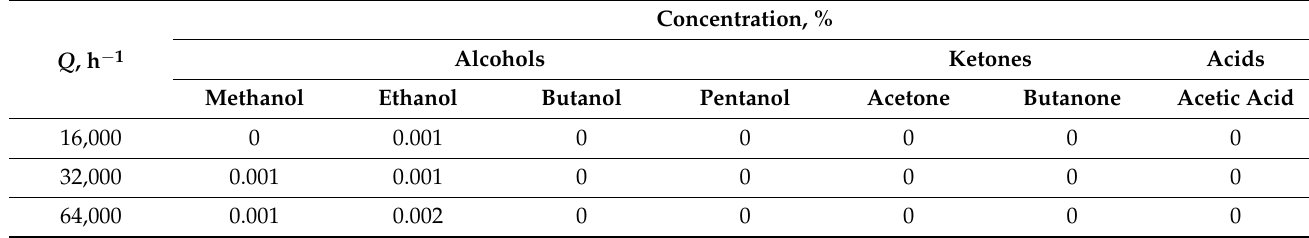
Table 7. Composition of the product liquids (Ni-Co, 780 ◦ C).